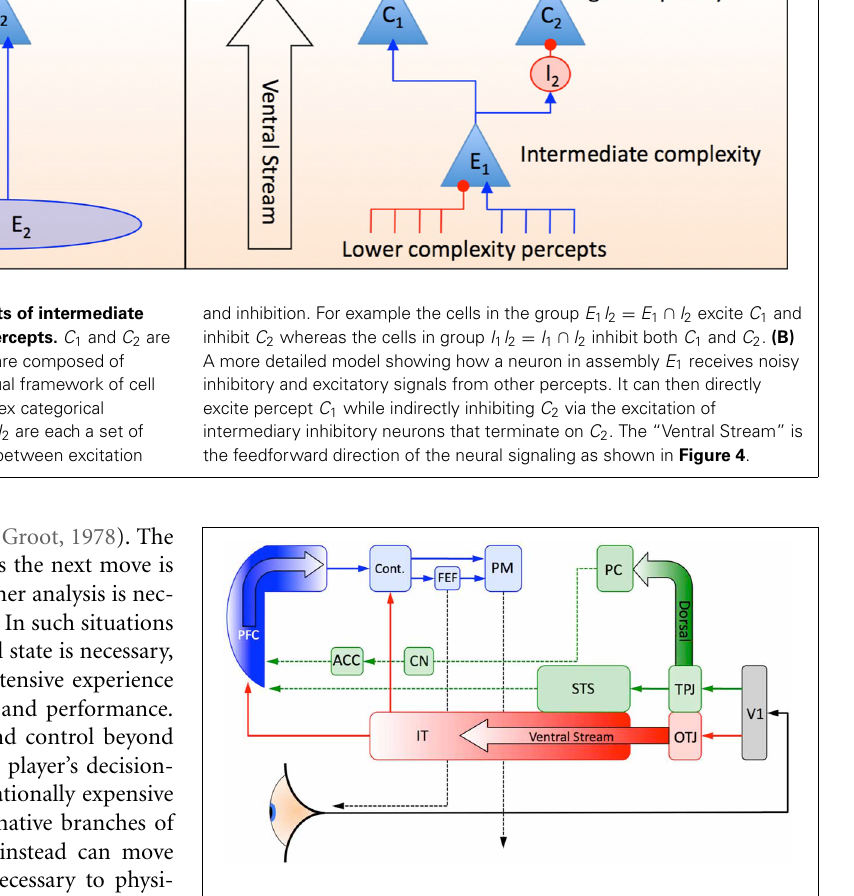
FIGURE 4 | A schematic representation of the major cortical pathways of expertise: feedforward visual processing (red), strategic Theory of Mind and associated reward mechanisms (green) and top down planning and control (blue) discussed in the main text. The anterior-most frontal regions integrate information from a strategic ToM network and a perceptual network for recognizing individual items of intermediate complexity. The categorical signal projects to a region posterior to the anterior regions of the frontal cortex that are associated with high level strategic planning and control processes. This allows for the possibility of the contextual signal to rapidly activate an eye saccade (and other motor activities) to a strategically relevant portion of the visual field without passing through the top–down planning areas in the PFC. Such search guided by implicitly learned visual cues was established by Chun and Jiang (1998, 1999) for large but relatively simple environments. V1, visual area 1 in the occipital cortex; OTJ, occipitotemporal junction; TPJ, temporoparietal junction; STS, superior temporal sulcus; IT, inferotemporal cortex; PC, precuneus; CN, caudate nucleus; ACC, anterior cingulate cortex; PFC, prefrontal cortex; Cont., visual context integration; FEF, frontal eye field; PM, primary motor